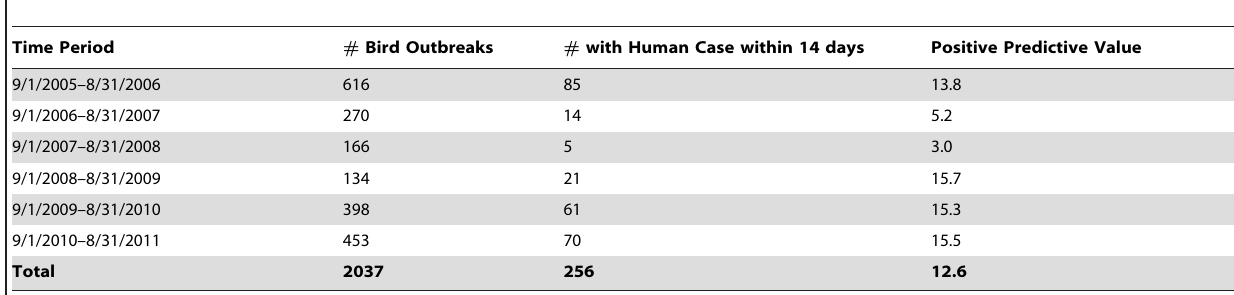
Table 3. Positive Predictive Value (PPV) for bird outbreaks predicting the occurrence of a human case of H5N1 HPAI in the same governorate within the next 14